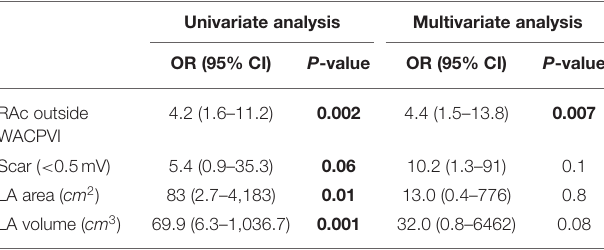
TABLE 4 | Predictors of AF recurrence analysis after WACPVI ablation.